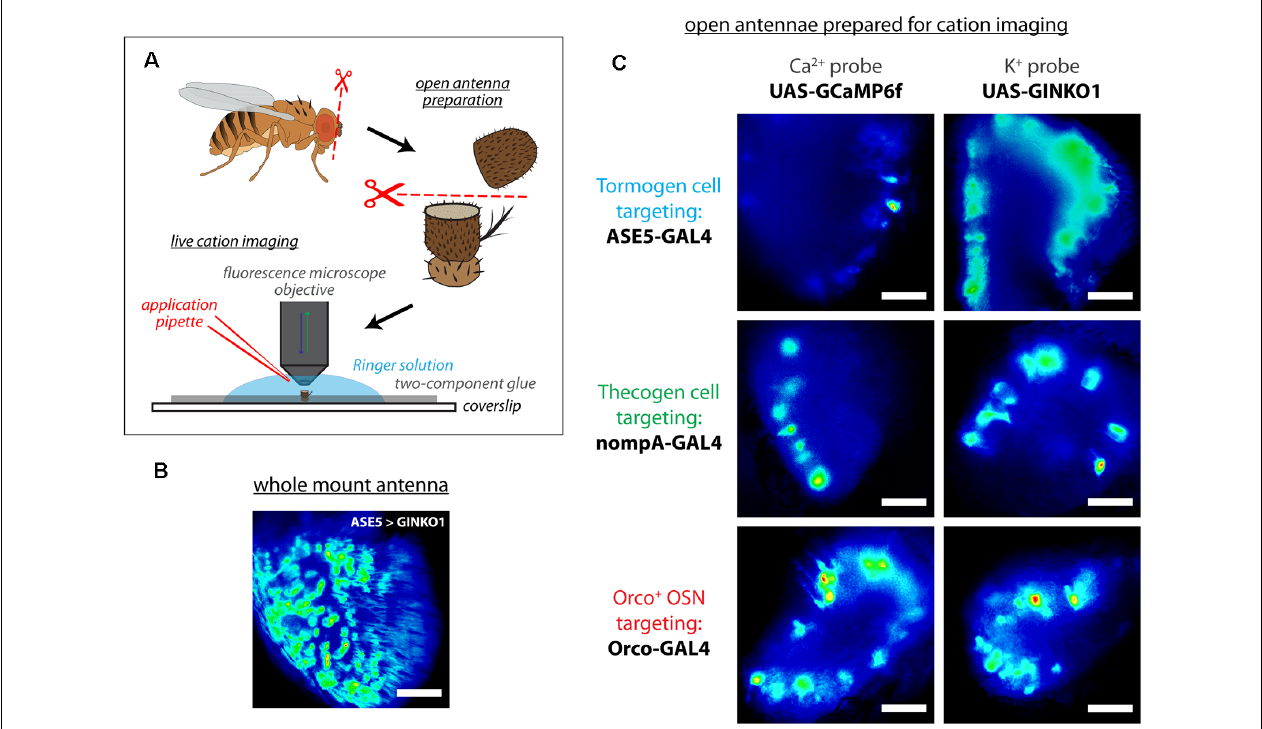
FIGURE 2 | Live cation imaging using open Drosophila antenna preparations. (A) Schematic of the cation imaging workflow . D. melanogaster antennae are first excised, then deposited into Drosophila Ringer solution and held in place with two-component glue prior to bisection using micro-scissors. Every antenna is bisected to better reveal the funiculus interior for live cell imaging with fluorescence microscopy. (B) A non-bisected antennal whole mount unsuitable for imaging cells, for comparison. Scale bar: 20 µ m. (C) Exemplar fluorescence micrographs of tormogen support cells, thecogen support cells, and the Orco-positive subset of olfactory sensory neurons, prior to cation imaging (targeted using nompA-, ASE5, and Orco-GAL4 drivers, respectively). Cell type-specific fluorescent reporter expression of Ca 2+ indicator GCaMP6f and K + indicator GINKO1 are shown by column. Scale bars: 20 µ